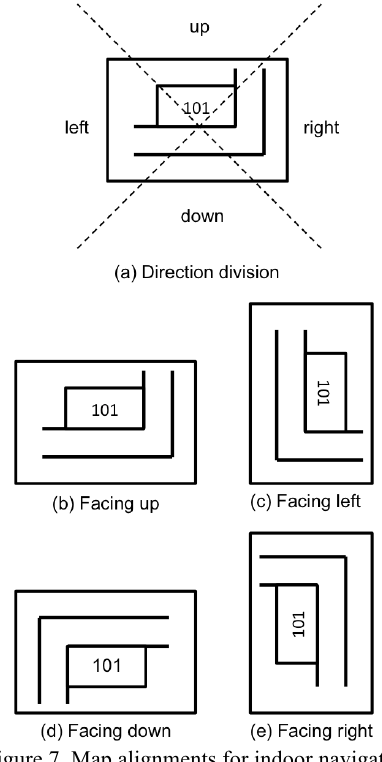
Figure 7. Map alignments for indoor